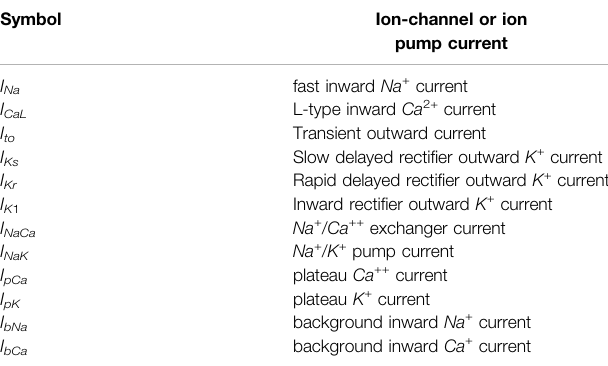
TABLE 1| Thevarious ioniccurrentsintheTP06model[43].Thedetails oftheion- channel and ion-pump equations for the currents and the parameter values that we use for the TP06 model are given in the Supplementary Material